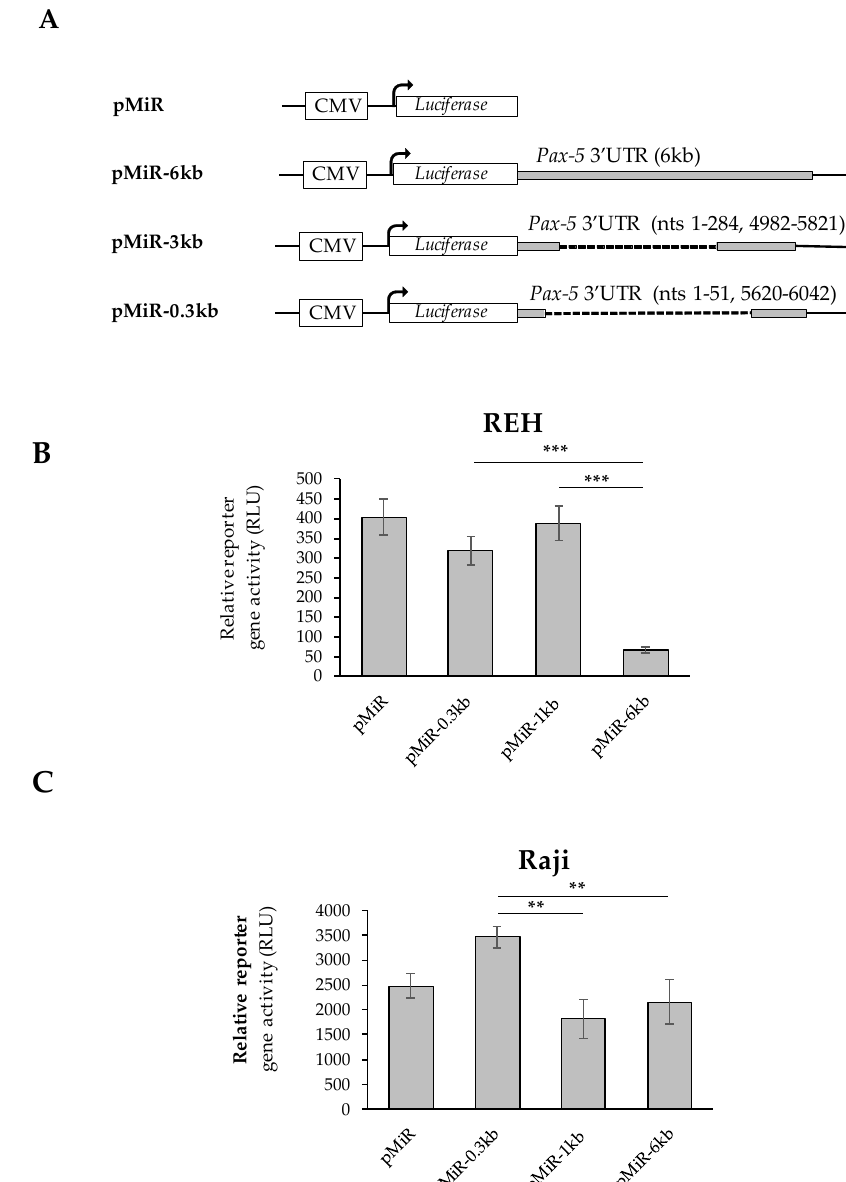
Figure 4. Effects of Pax-5 3 (cid:48) UTR editing on translation potential. The most prominent spliced 3 (cid:48) UTR isoforms from Pax-5 transcripts isolated from B-cells were ( A ) cloned downstream of the firefly luciferase reporter gene. The pMiR-REPORT constructs were either left empty (pMiR) or contained a full-length Pax-5 3 (cid:48) UTR (pMiR-6kb); a 3 (cid:48) UTR variant of 1 kb (pMiR-1kb) or a 3 (cid:48) UTR variant of 0.3 kb (pMiR-0.3kb). The respective lengths and structures from each 3 (cid:48) UTR isoform and plasmid are indicated with their respective nucleotide (nt) positions relative to the stop codon. ( B ) REH and ( C ) Raji B-cell lines were transiently transfected with pMiR reporter constructs and evaluated for relative firefly luciferase activity. Relative light units (RLUs) were normalized for each transfection condition using qRT-PCR on puromycin (a resistance gene located on the backbone of the reporter plasmid). The presented data are the calculated means of three independent samples, where statistical analysis by t -test indicates significant differences with respect to control cells (** p < 0.01 and *** p < 0.001).